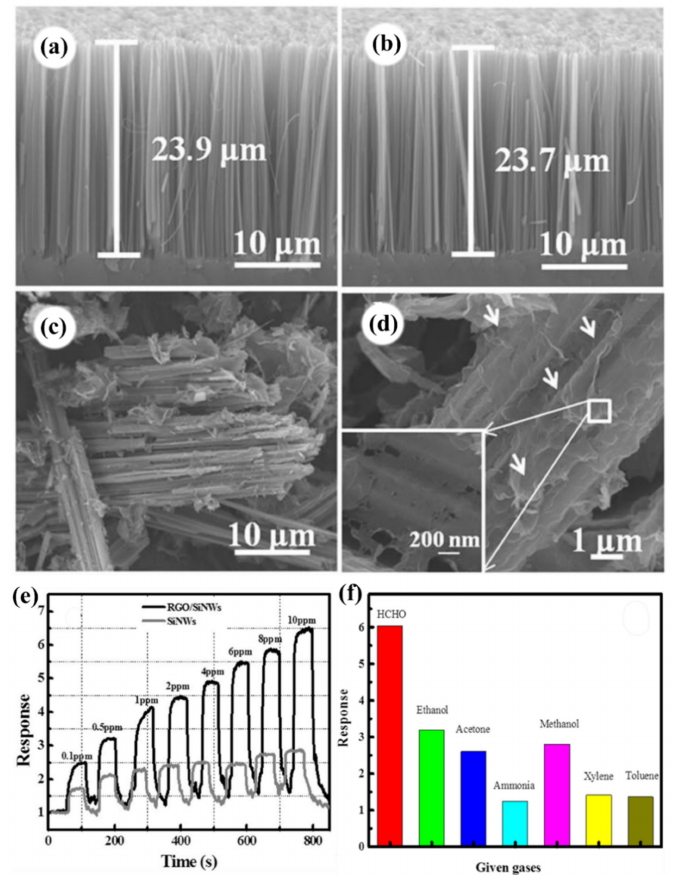
Figure 27. Cross-sectional SEM images of ( a ) n-SiNWs. ( b ) p-SiNWs. ( c ) SEM image of RGO@n-SiNWs with HF treatment, ( d ) Zoomed-in SEM image of RGO@n-SiNWs with HF treatment, ( e ) dynamic response of n-SiNWs and RGO@n-SiNWs from 0.1 to 10 ppm HCHO, ( f ) The response of n-SiNWs and RGO@n-SiNWs for seven types of common VOCs (10 ppm) at 300 ◦ C. Reproduced from